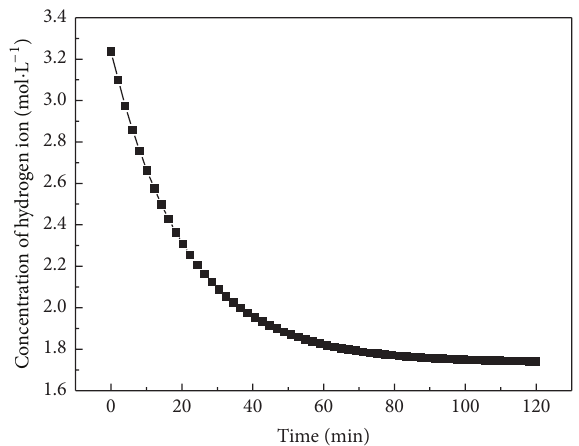
Figure 5: Hydrogen ion concentration at a given time (at 90 ∘